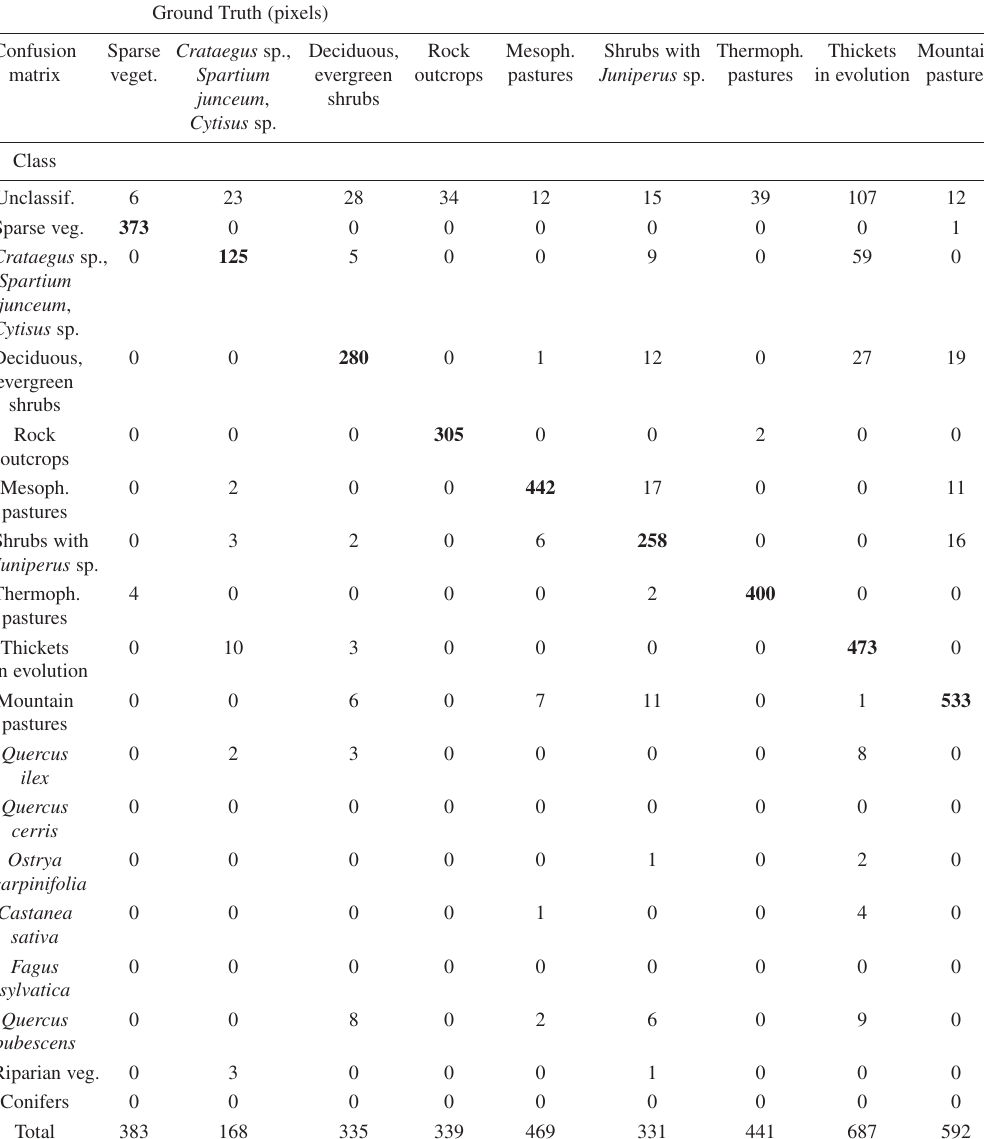
Table IV. Confusion matrix. Ground Truth